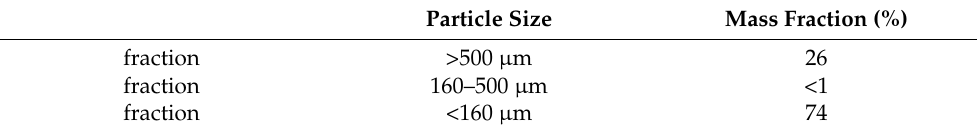
Table 2. Sediment composition.